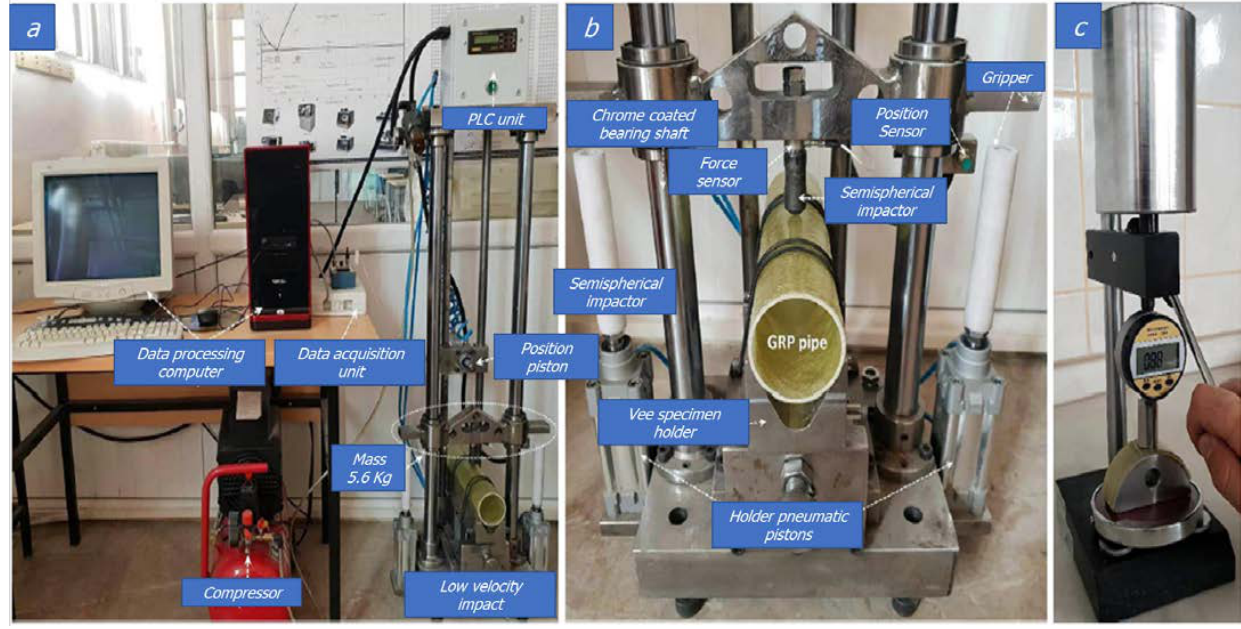
Figure 2. ( a ) Low-velocity impact test stand and data logging system, ( b ) anti-rebound system, and ( c ) shore D hardness tester [37,38].